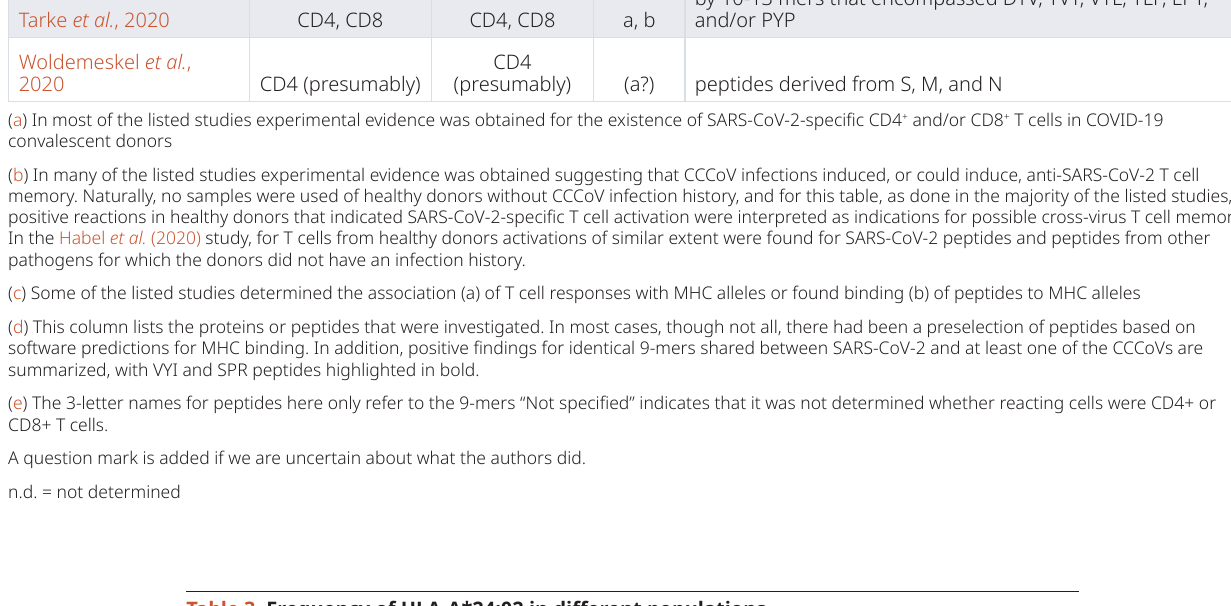
Table 3. Frequency of HLA-A*24:02 in different